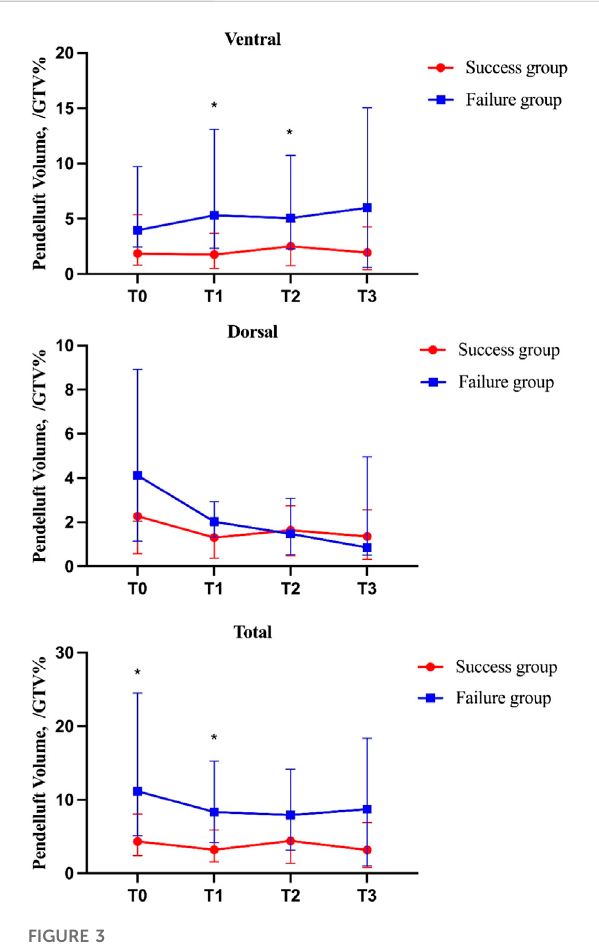
FIGURE 3 Pendelluft amplitude in each region measured by electrical impedancetomography(EIT)duringSBT.EITimagingwasdividedinto two regions of interest: dorsal and ventral, Total = dorsal + ventral. Pendelluft volume was recorded every 10 min including 10 min baseline(T0), SBT_10 min(T1), SBT_20 min(T2), SBT_30min(T3) with EIT./GTV%, pendelluft amplitude to was tidal variation ratio in percent. The curves in the fi gure represent the median and upper and lower quartiles.